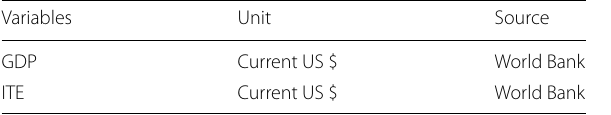
Table 1 Variables definition Variables